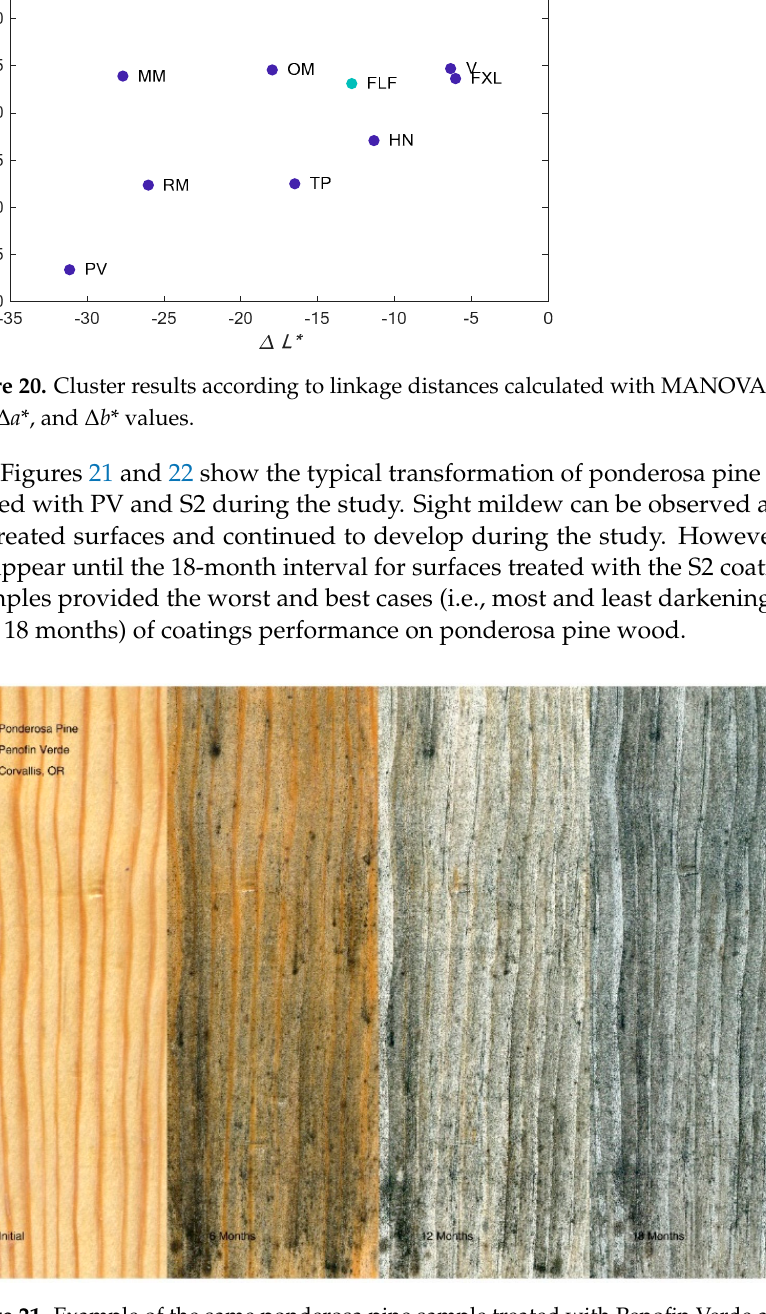
Figure 21. Example of the same ponderosa pine sample treated with Penofin Verde and exposed on a test fence near Corvallis, OR for 0, 6, 12, and 18 months (left to right).